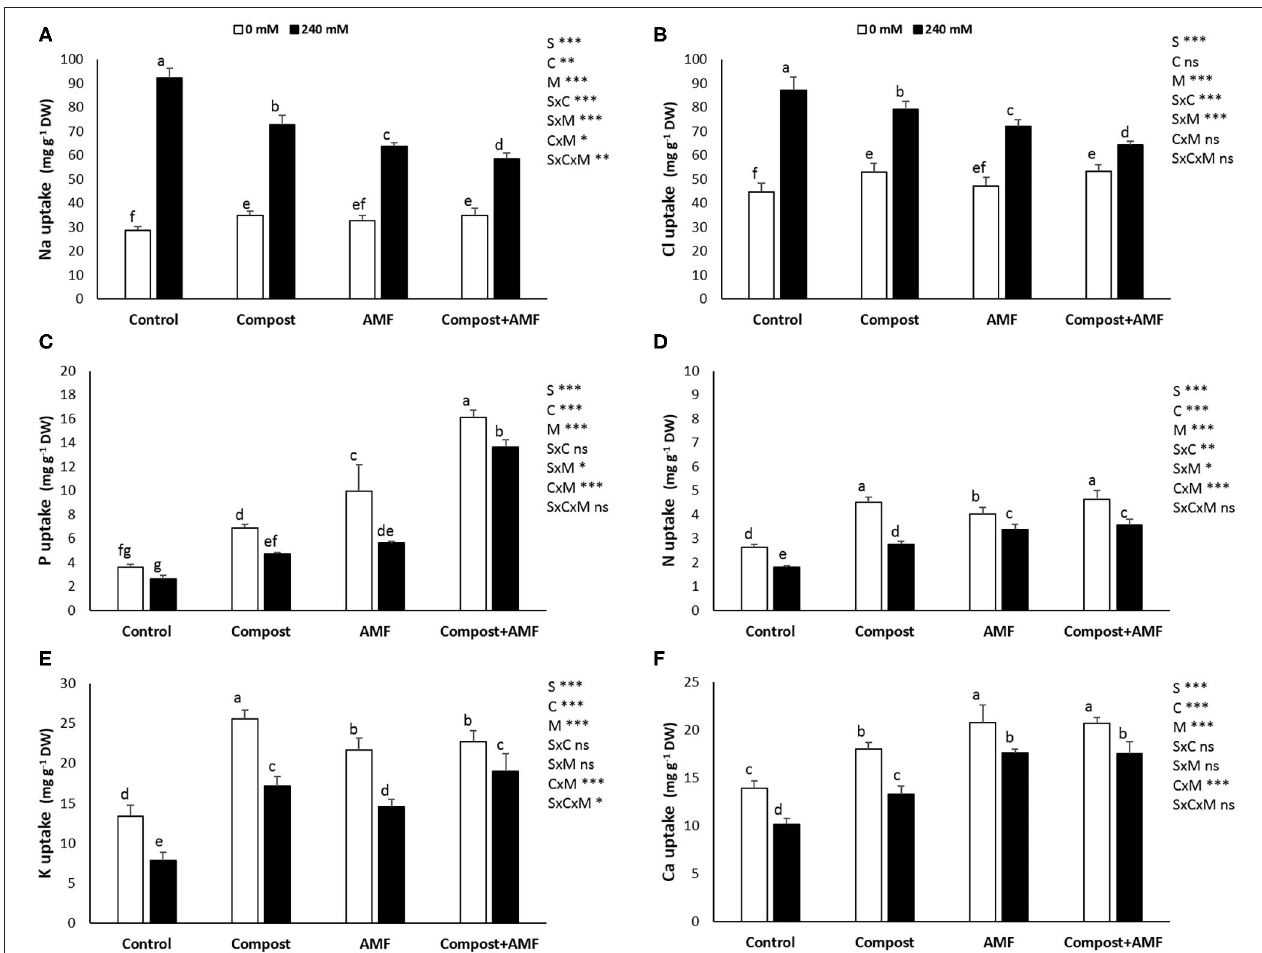
FIGURE 1 | Mineral concentrations ( A , sodium, Na + ; B , chloride, Cl − ; C , phosphorous, P; D , nitrogen, N; E , potassium, K + ; and F , calcium, Ca 2 + ) of date palm plants under saline and non-saline conditions after application of compost and AMF alone or in combination. The values of each parameter labeled by different letters indicate significant differences assessed by Duncan’s test after performing a three-way MANOVA ( P < 0.05). ns non-significant; *significant at P < 0.05; **significant at P < 0.005; ***significant at P <